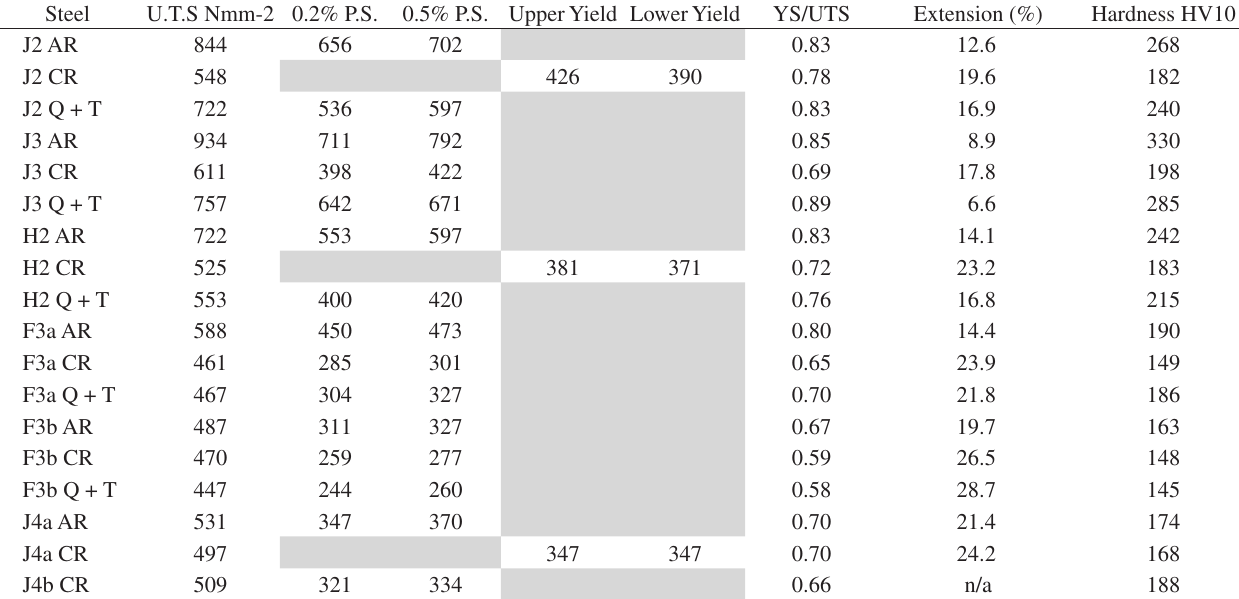
Table 2. Hardness and tensile properties of the 60 kg melts in the various processed conditions. Steel